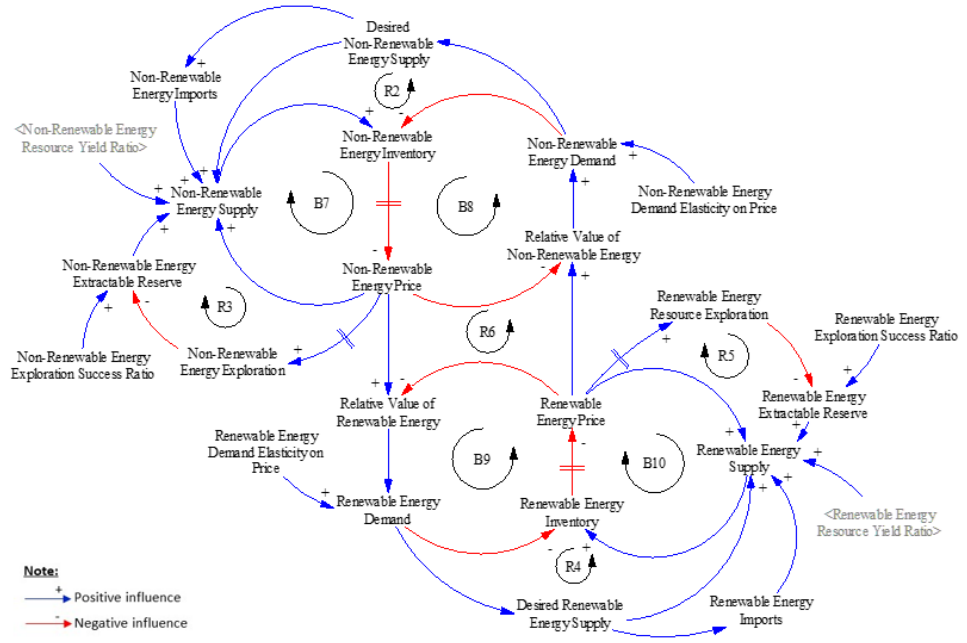
Figure 2. Substitution between non-renewable energy and renewable energy. Blue arrows are paired with (+) sign to indicate positive influence on the variable, red arrows paired with ( − ) indicate negative influence.